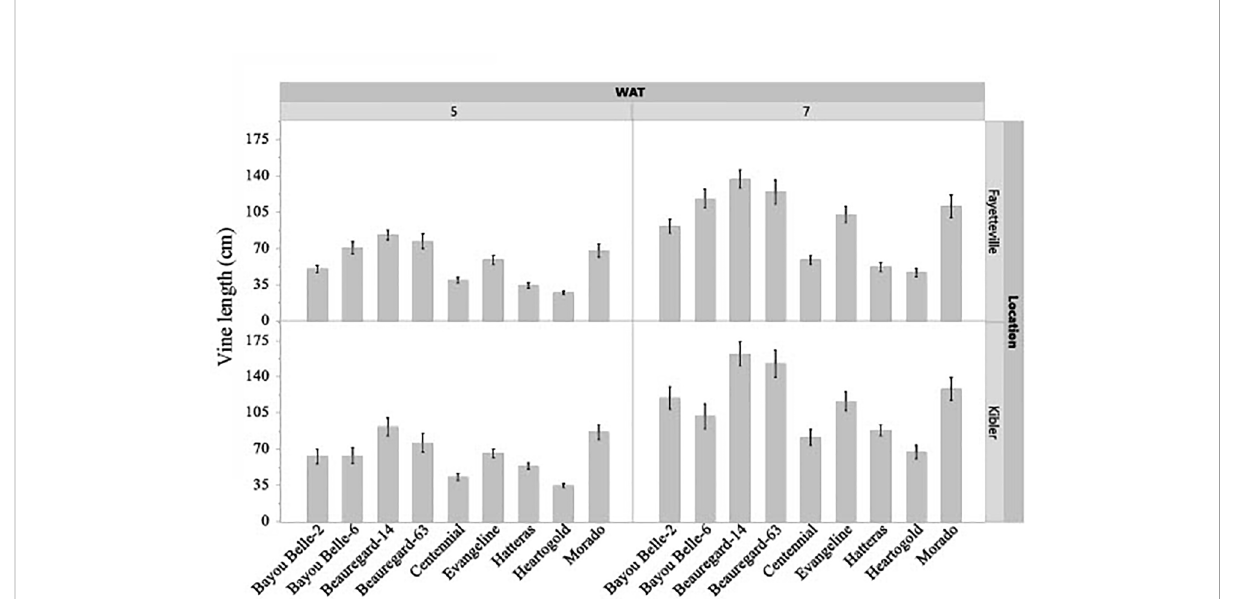
FIGURE 3 Sweetpotato vine length (cm) averaged across weed species at 5 and 7 weeks after transplanting (WAT) in Kibler and Fayetteville, AR, 2021. LSD to compare cultivars within location Fayetteville at 5 and 7 WAT: 7 cm; 10 cm. LSD to compare cultivars within location Kibler at 5 and 7 WAT: 9 cm; 12 cm. Bars represent standard error.